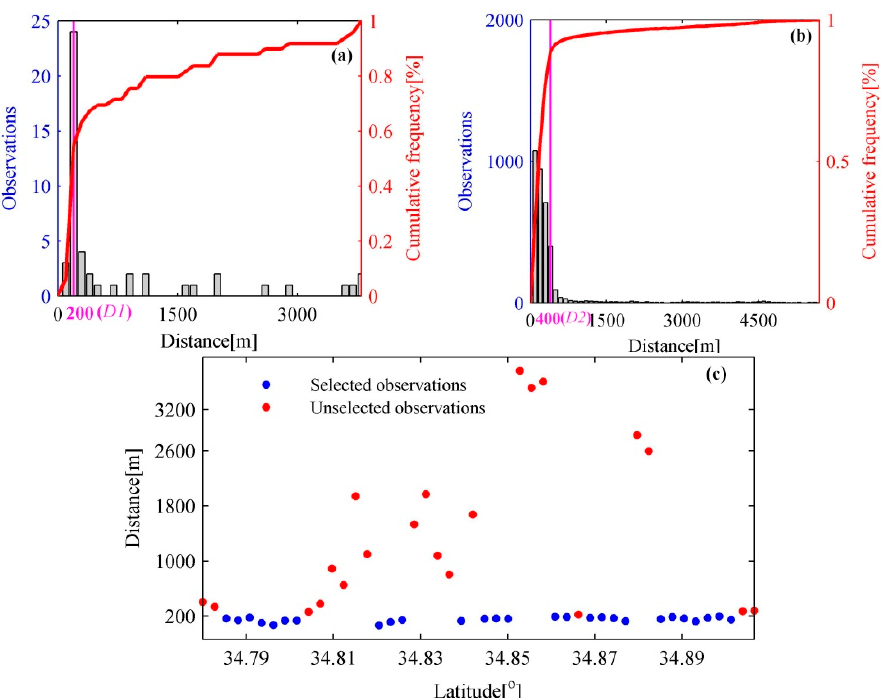
Figure 5. ( a ) Cumulative distribution function (CDF) and D1 from the track in Figure 3a. ( b ) CDF and D2 from all tracks over Ngoring Lake. Magenta lines represent the locations of D1 and D2 . ( c ) The selected results.